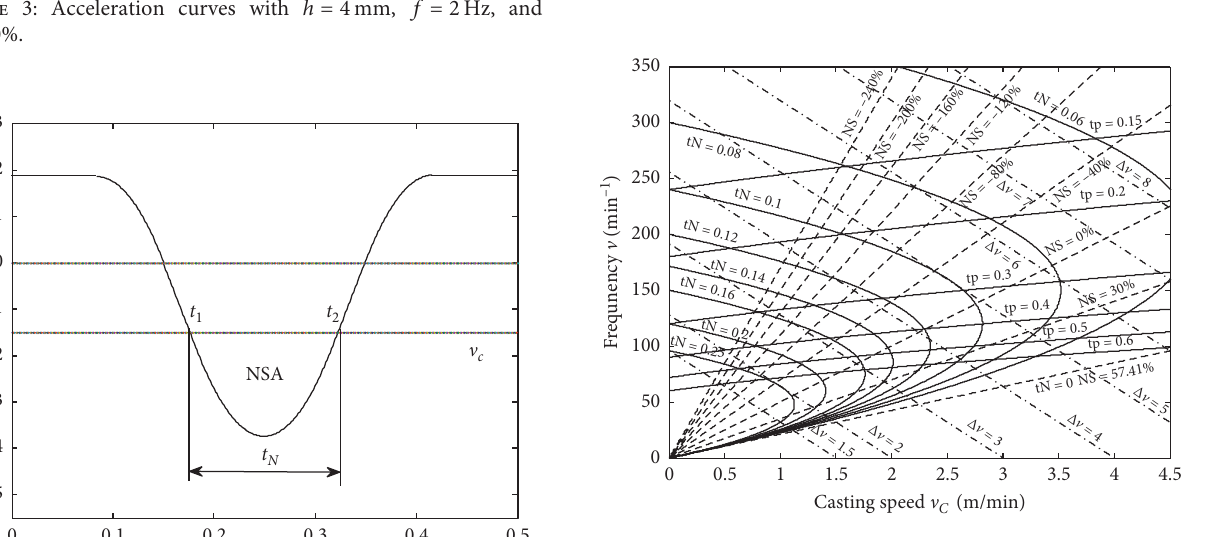
Figure 5: Negative strip time curves.